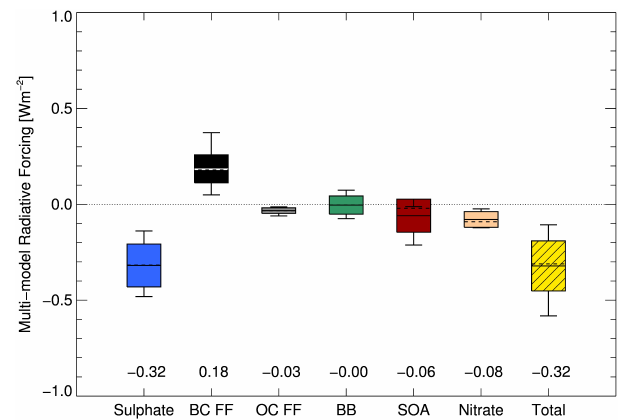
Fig. 7. Component and total RF. Total RF has been modified for missing components in individual models. Solid lines inside the boxes show the model mean, dashed lines show the median. The boxes indicate one standard deviation, while the whiskers indicate the max and min of the